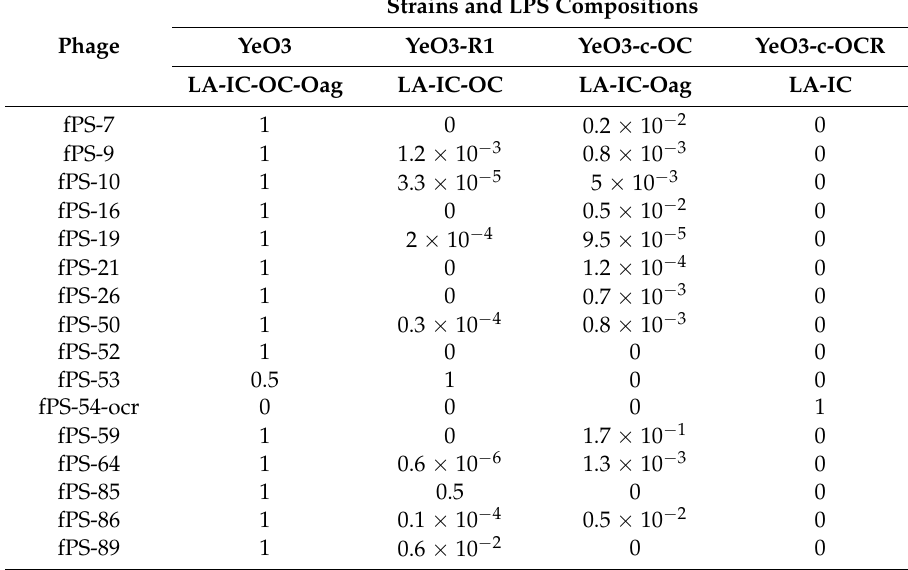
Table 5. The EOP of the phages on Y. enterocolitica serotype O:3 LPS mutants. The EOP on the preferred host was set to